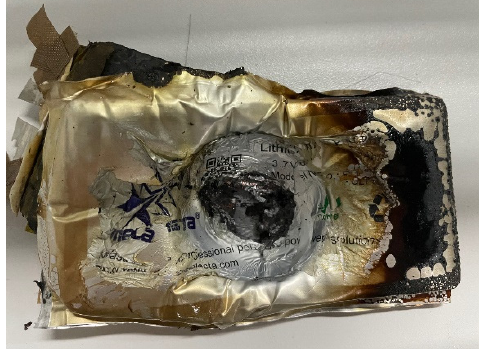
Figure 15. Post-experiment battery.